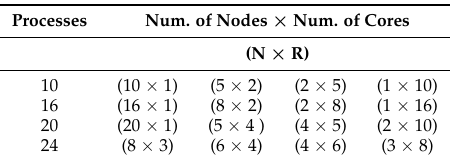
Table 7. Arrangement of processing